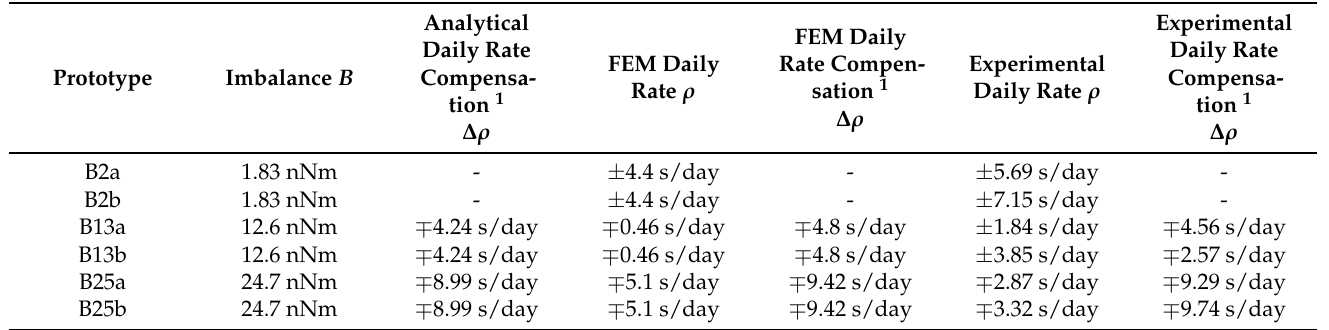
Table 1. Experimental, FEM and analytical daily rate compensation achieved by offsetting the COM of the co-RCC prototype along its axis of